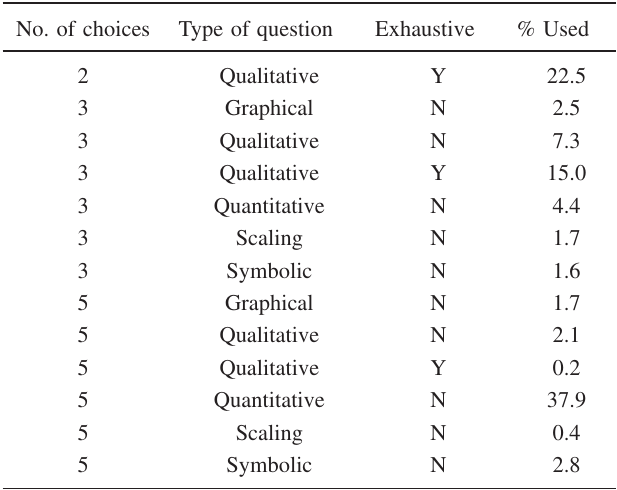
TABLE III. A list of the types of questions used on midterm exams in our calculus-based E and M course (cid:1) 1003 questions in total (cid:2) .